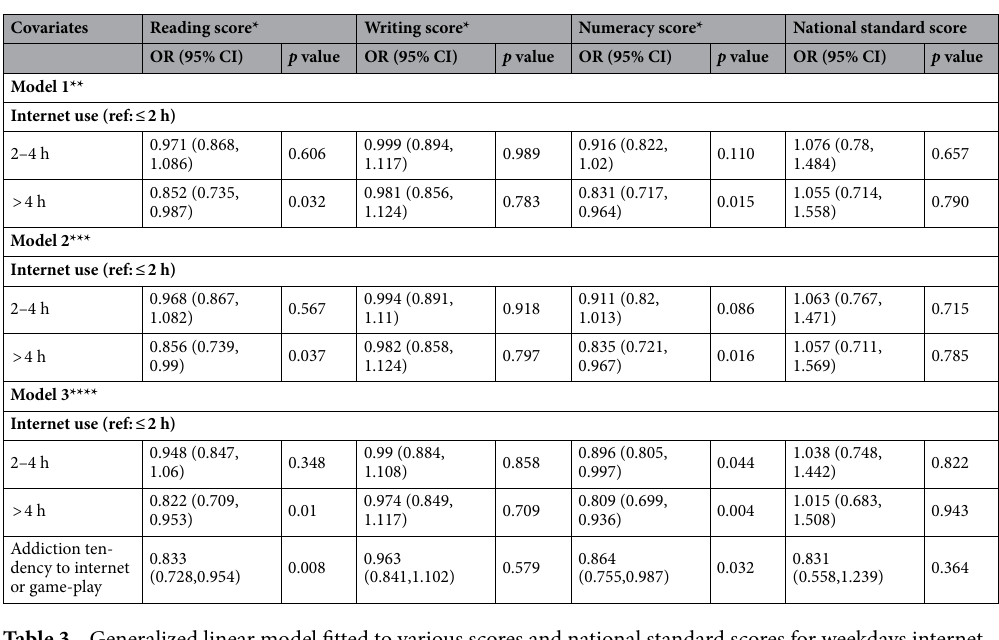
Table 3. Generalized linear model fitted to various scores and national standard scores for weekdays internet use adjusting the behavioral and sociodemographic factors, as well as survey weights. *Standardized (mean of 0 and a standard deviation of 1). **The model was adjusted for age and sex of the child, household income, primary carer’s education and family type. ***Model 2 was adjusted for age and sex of the child,